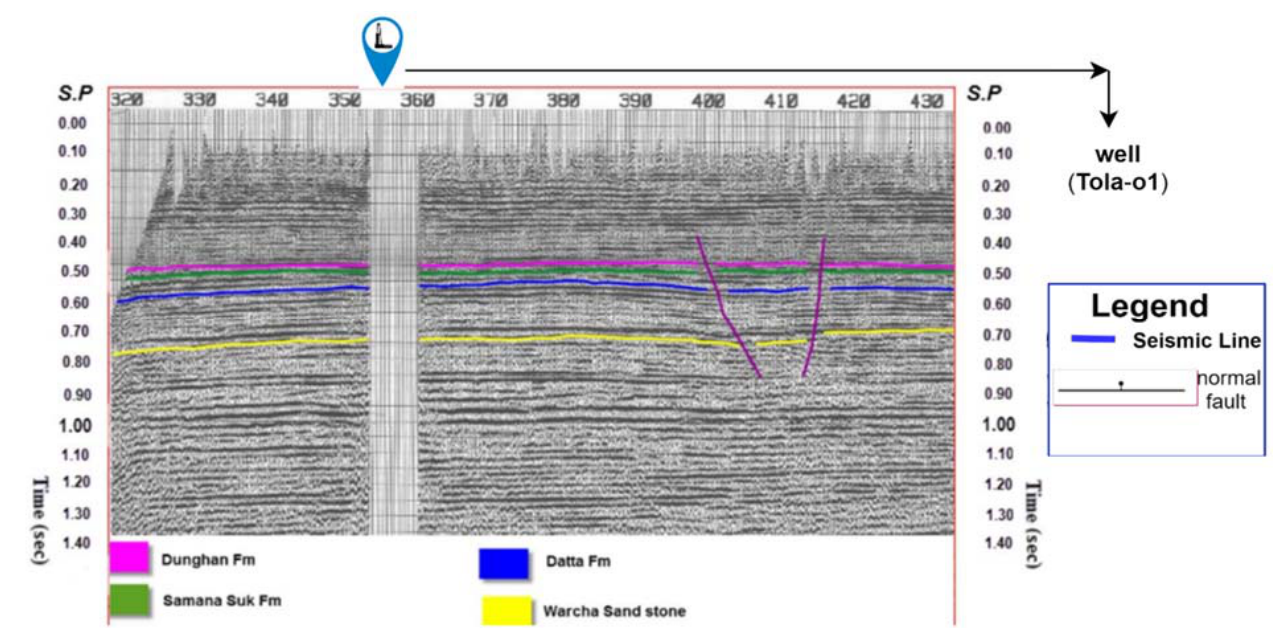
Figure 7. Marked seismic horizons of 875-KBR-231 line.